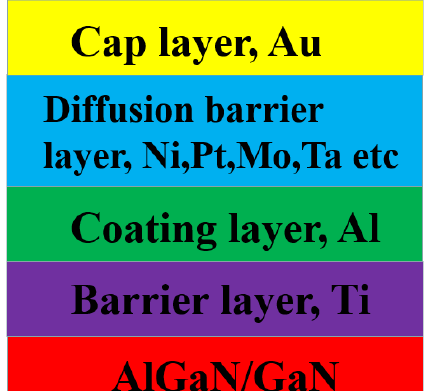
Figure 5. Schematic structure of metal stacks used for forming ohmic contact to AlGaN/GaN HEMT.